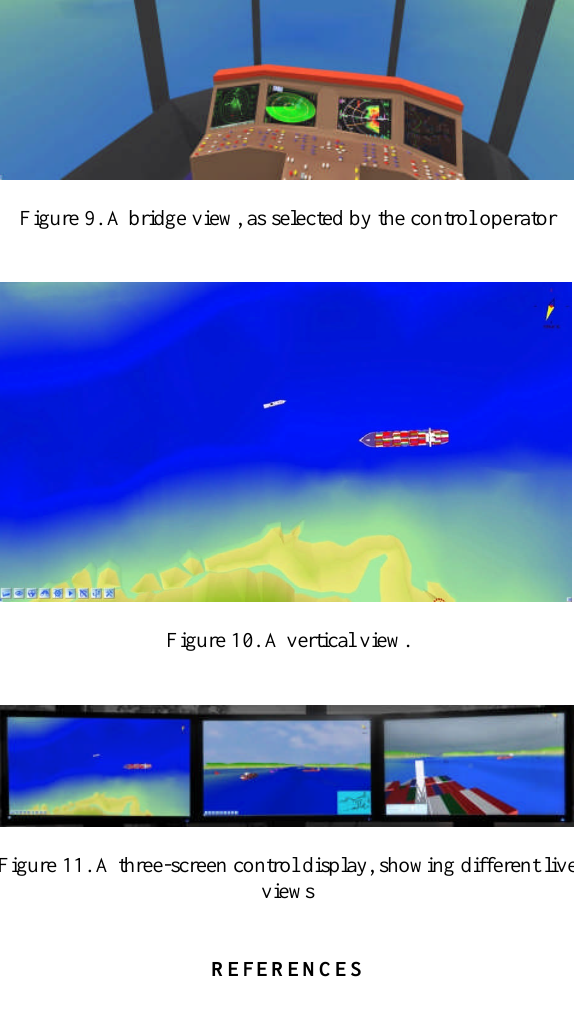
Figure 7. Manoeuvring an LNG tanker